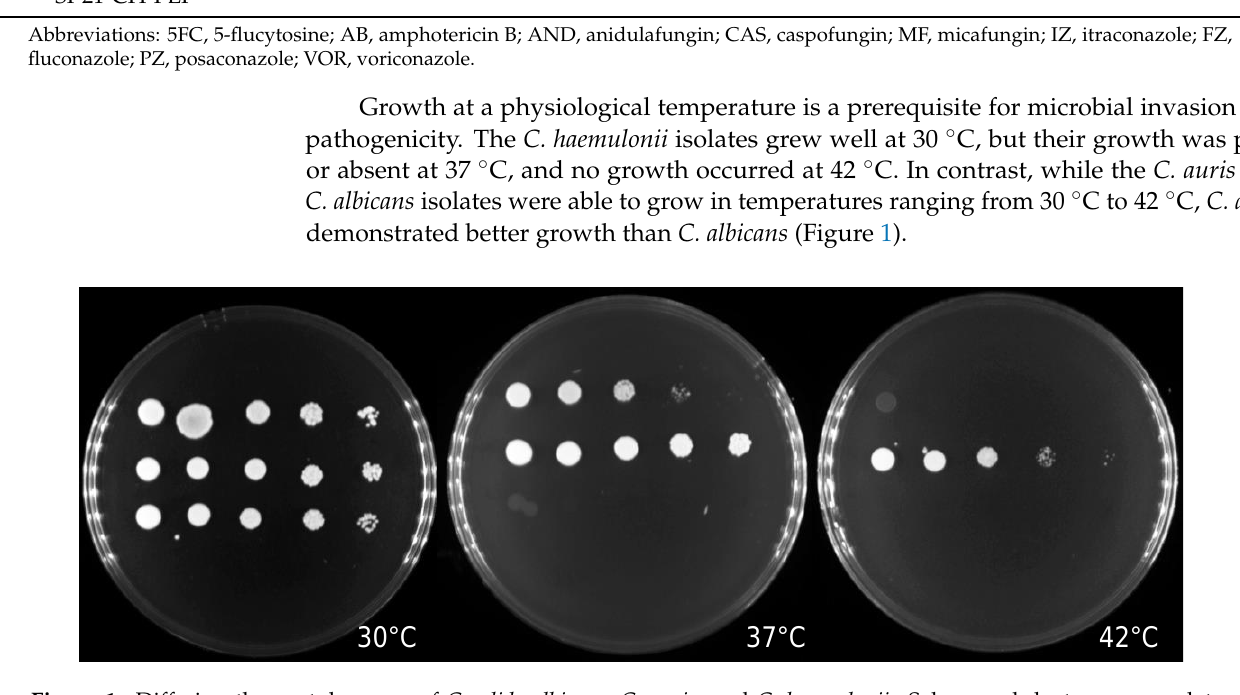
Figure 1. Differing thermotolerances of Candida albicans, C. auris, and C. haemulonii . Sabouraud dextrose agar plates showing growth of representative Candida strains after 48 h incubation at 30–42 ◦ C with serial dilution spots. Top row: C. albicans ATCC24433 as the control strain; middle row: C. auris strain SI-18-CAU-HEM; and bottom row: C. haemulonii strain